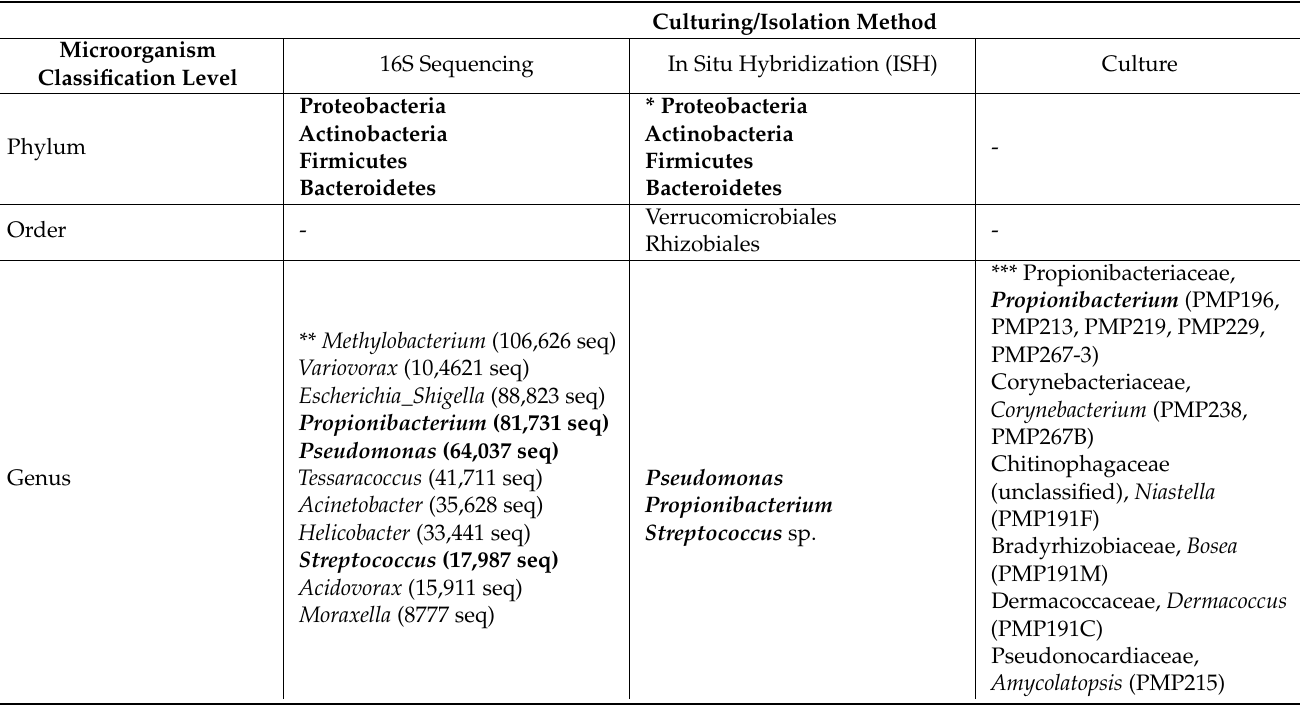
Table 1. Microorganisms identified and/or isolated from PMP tumors and mucin in Gilbreath et al.